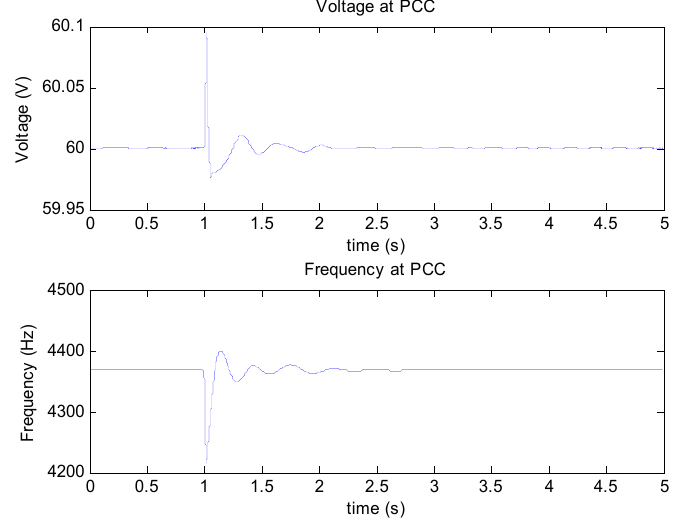
Figure 12. Reactive power sharing and active power sharing in Scenario I. Solid line, DG1; dash line, DG2; dash-dot line, DG3; dot line, DG4.